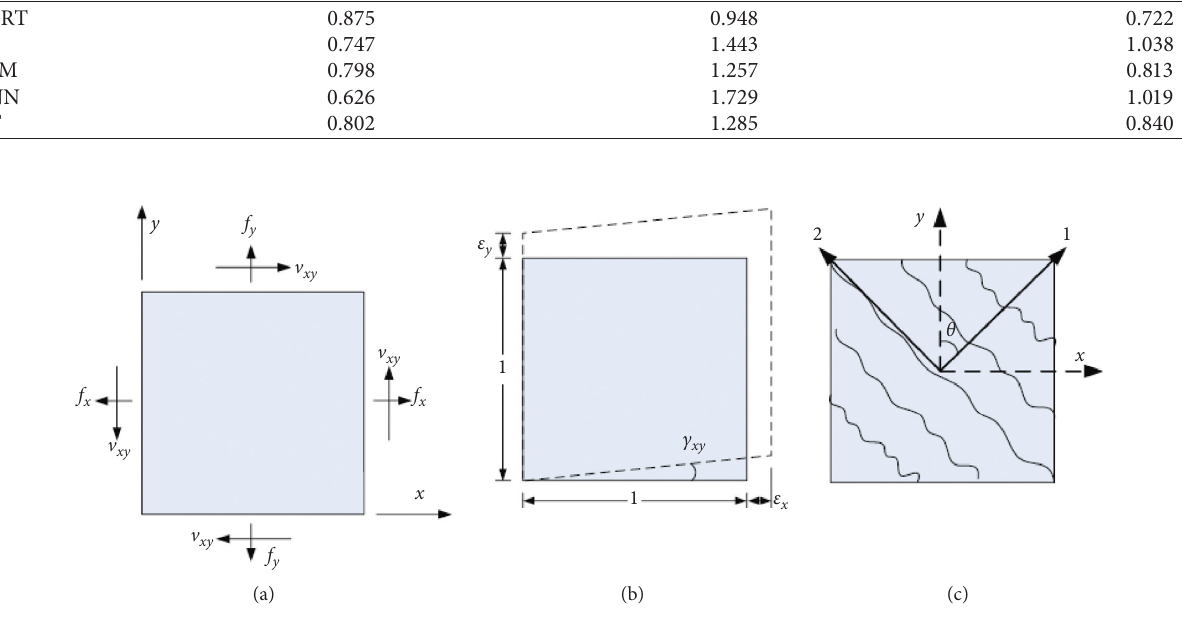
Figure 4: The basic RC element state. (a) Stress state. (b) Strain state. (c) Principal